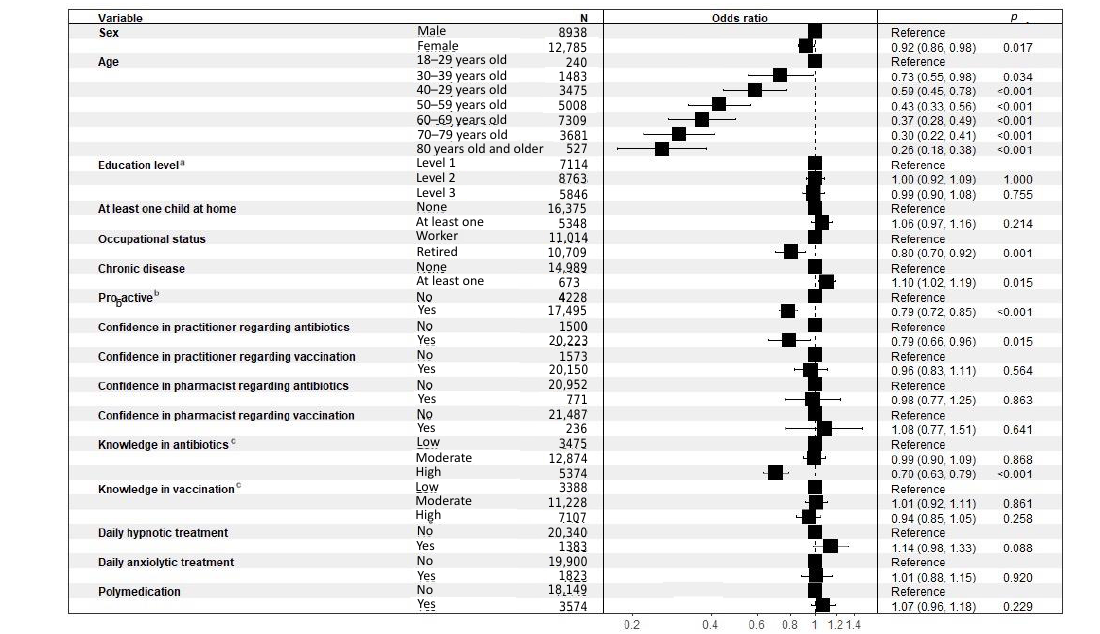
Figure 5. Binary logistic regressions performed to evaluate the determinants of the misuse of antibiotics. a Level 1: Level of education below “Baccalaureate” (French high school diploma) degree, Level 2: Level of education greater than or equal to “Baccalaureate” degree and less than or equal to “Baccalaureate” degree plus 2 years, Level 3: Level of study higher than “Baccalaureate” degree plus 2 years; b Proactive: ((asks physician for antibiotics) OR (if taking meds, has already discussed it with physician/pharmacist on own initiative) OR (if med for better sleep, has already tried non-medication methods) OR (if medication for anxiety, has already tried non-medication methods)), c Low: 0 or 1 right answer, Moderate: 2 or 3 right answers, High: 4 right answers.